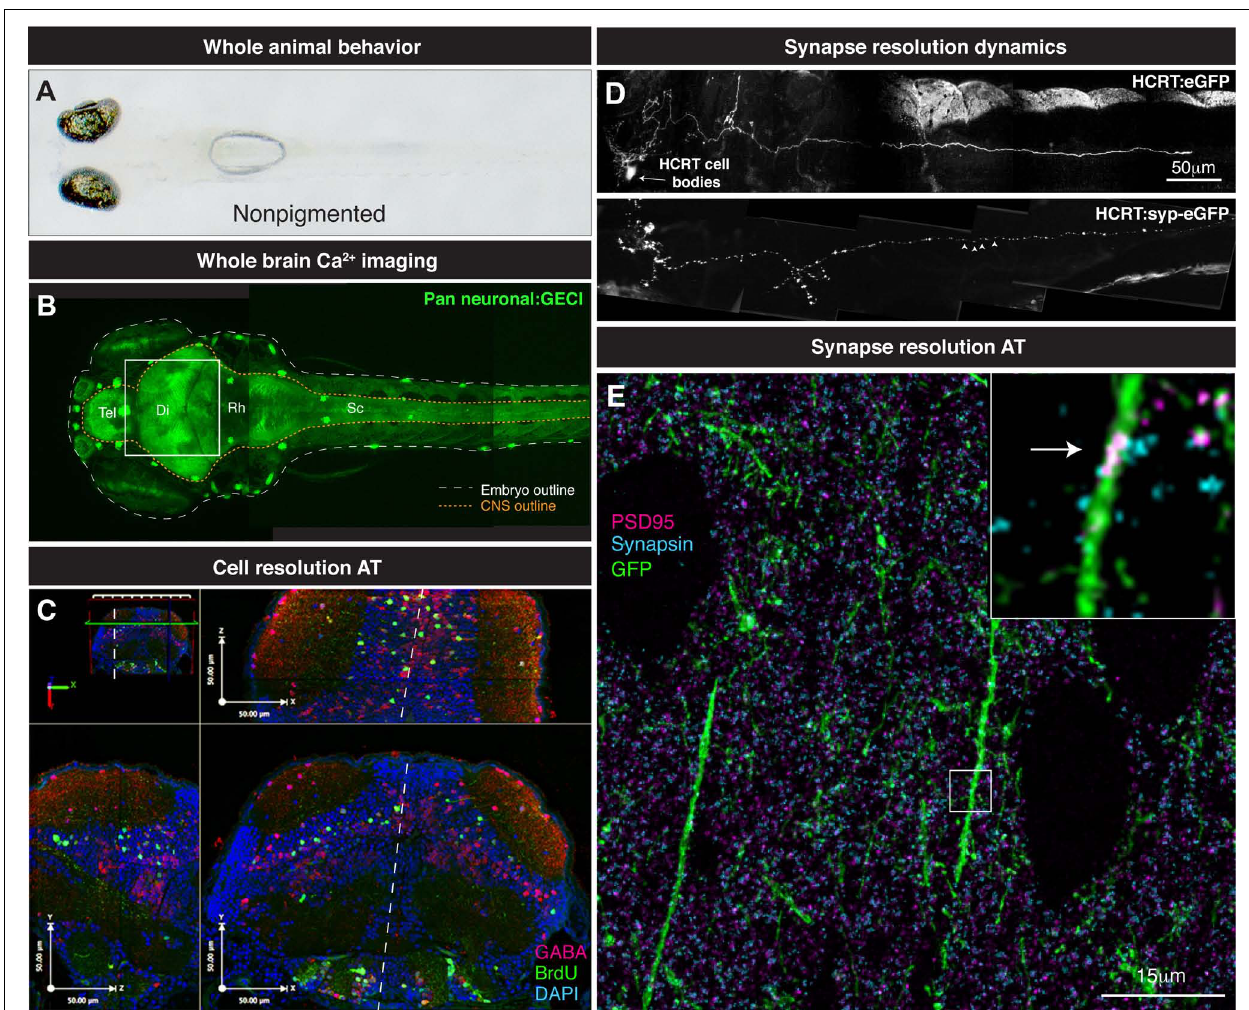
FIGURE 3 | From whole brain to single synapse. (A) Behavioral processes can be studied in non-pigmented (Nacre; mitfa mutant) species of zebrafish. (B) Two-photon volume image of 5 dpf zebrafish expressing GCaMP pan-neuronally, note the linear organization of the brain along the rostrocaudal axis from telencephalon (tel) to spinal cord (sc). (C) Various maximal projections (from area indicated in B by white box) of the 5 dpf zebrafish midbrain reconstructed after array tomography against GABA (magenta),